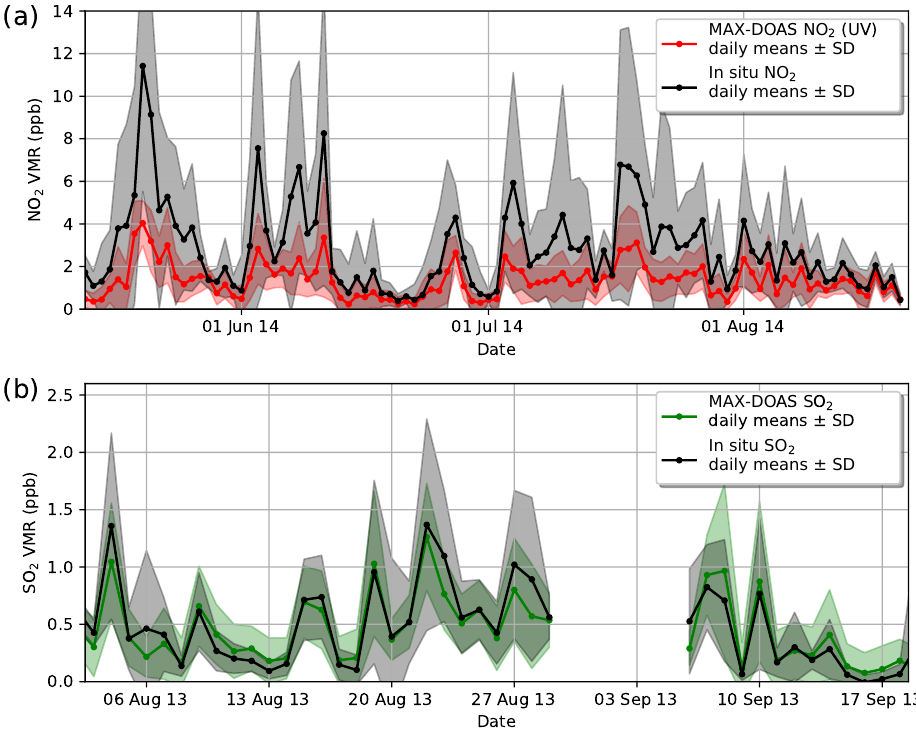
Figure 12. Comparison of MAX-DOAS (UV) and in situ daily mean VMRs of NO 2 (a) during summer 2014 and SO 2 (b) during summer 2013. Shaded areas show the standard deviation for each daily mean